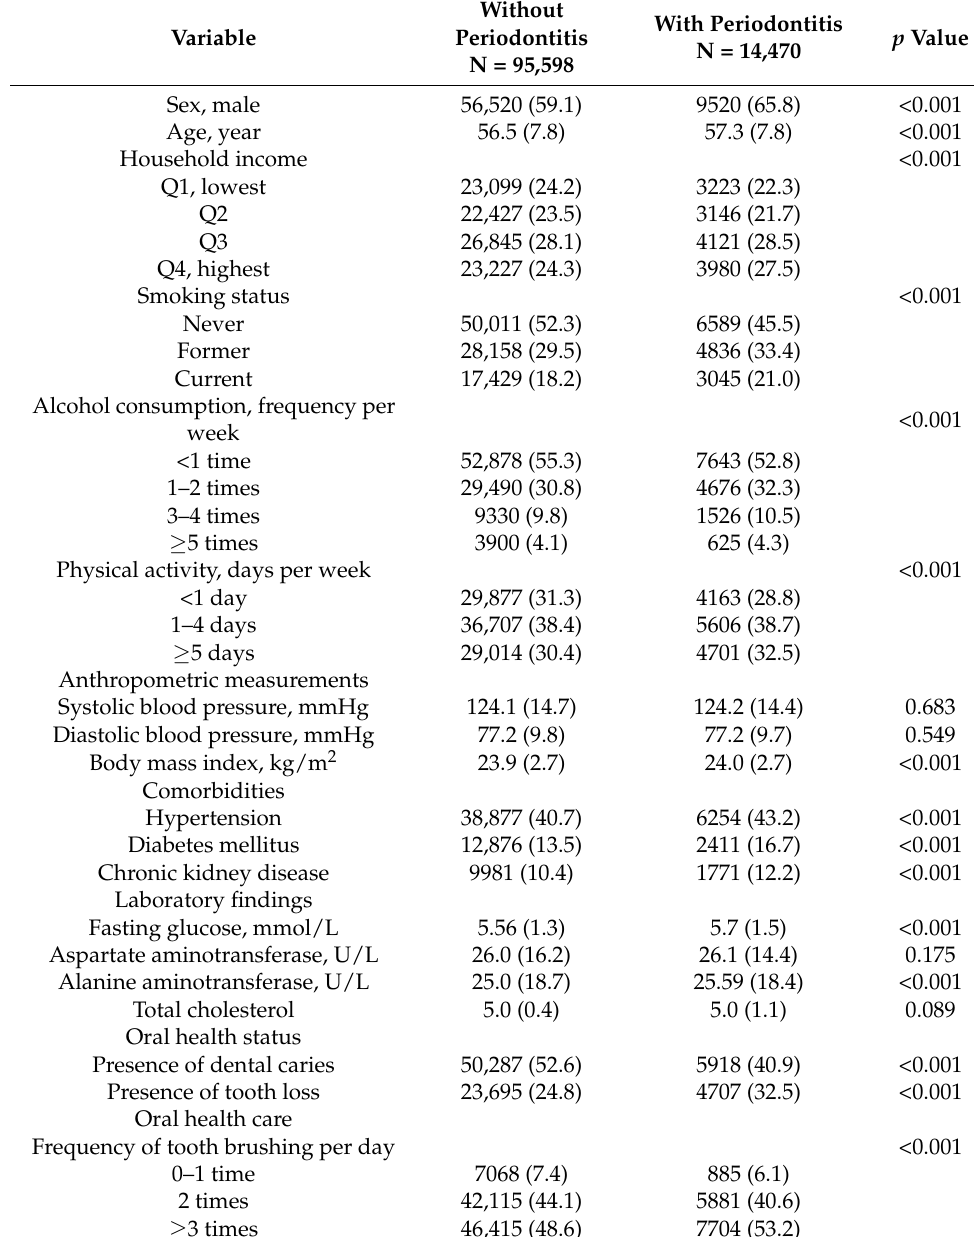
Table 3. Characteristics of patients according to the presence of